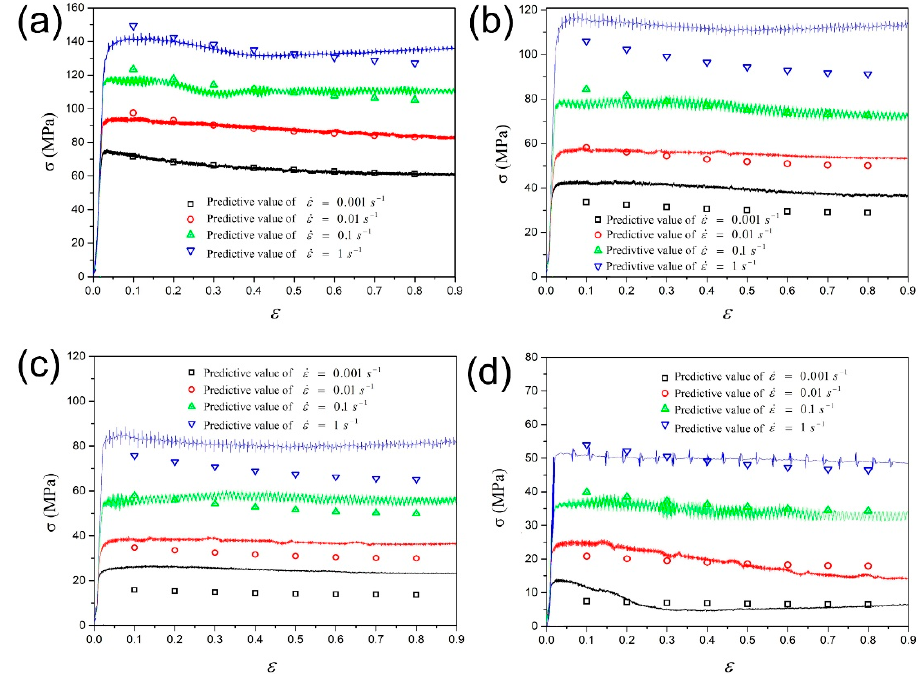
Figure 5. Comparison between the predictive value of the constitutive model fitted by a second- order polynomial and the experimental stress-strain curves at temperature of ( a ) 320 °C, ( b ) 380 °C, ( c ) 440 °C and ( d ) 500 °C, respectively.